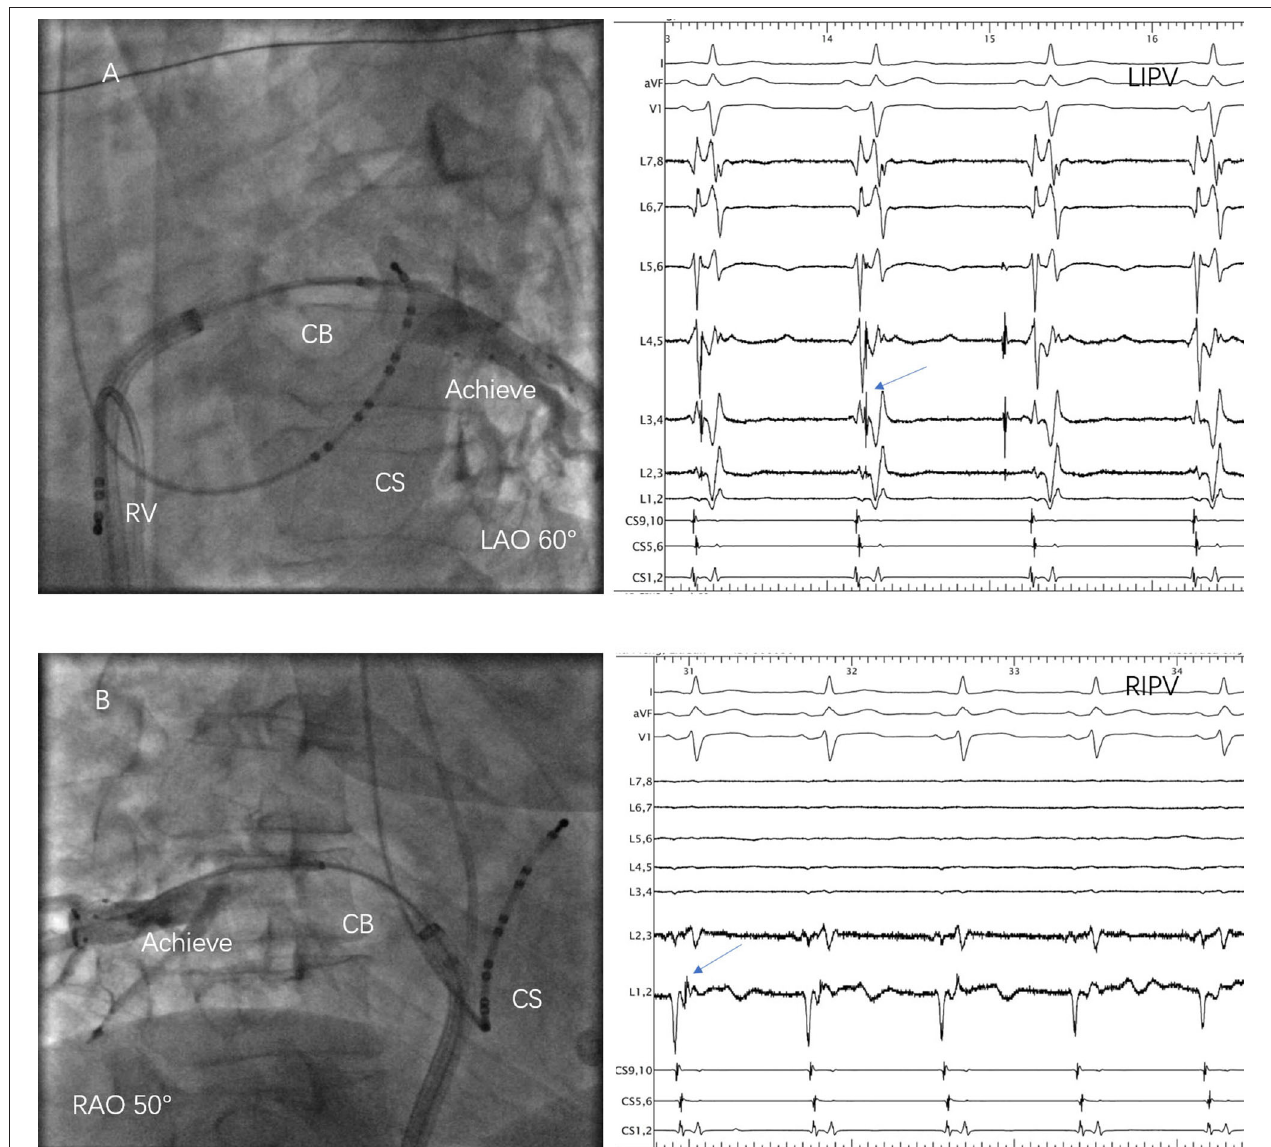
FIGURE 2 | Cryoballoon (CB) ablation of the common ostium of inferior pulmonary veins (COIPV). (A) The 28-mm CB was positioned at the ostium of left inferior pulmonary vein (LIPV) and the pulmonary vein (PV) potentials (arrow) were recorded in the Achieve catheter; (B) The 28-mm CB was positioned at the ostium of right inferior pulmonary vein (RIPV), LIPV, and the PV potentials (arrow) were recorded in the Achieve